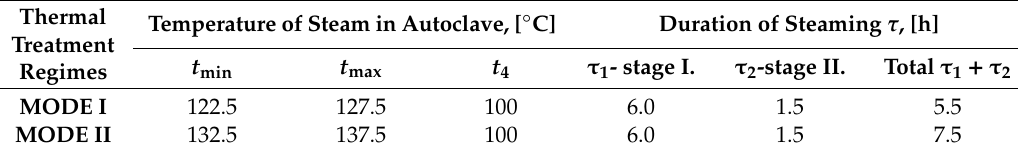
Figure 1. Mode of colour modification of birch wood with saturated water steam. Table 1. Regimes for thermal treatment of the birch wood using saturated water vapor.